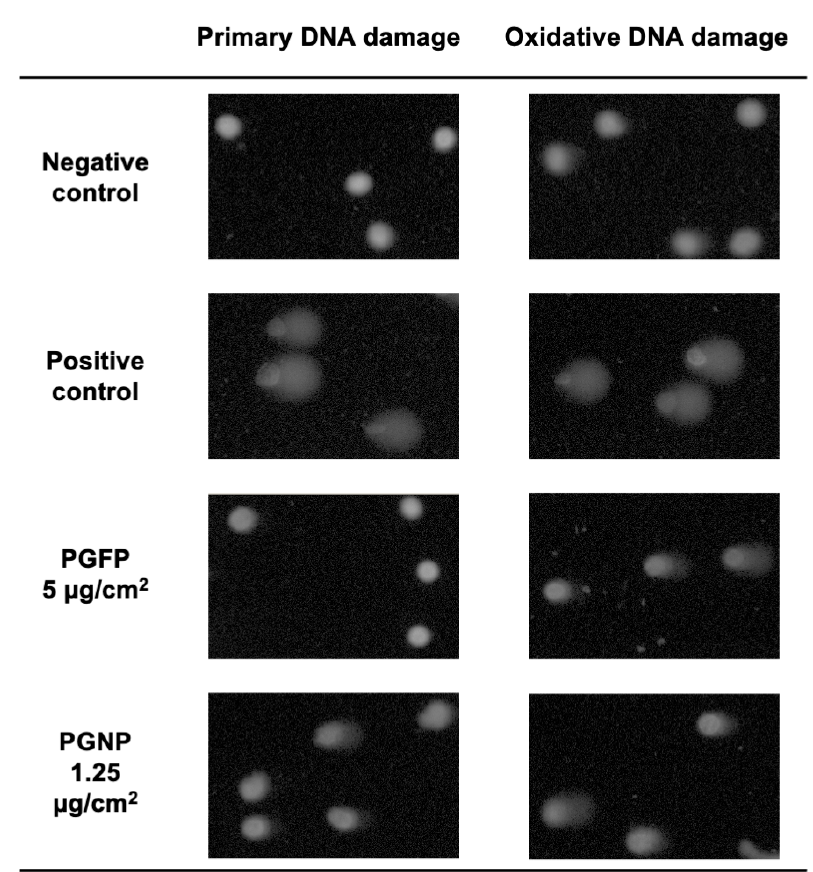
Figure A2. Representative comet assay images (100× magnification) of human alveolar epithelial cells exposed to the highest tested concentration of process-generated fine (PGFP) and nano-sized (PGNP) particles released during high-velocity oxy-fuel spraying (HVOF) and respective experimental controls.